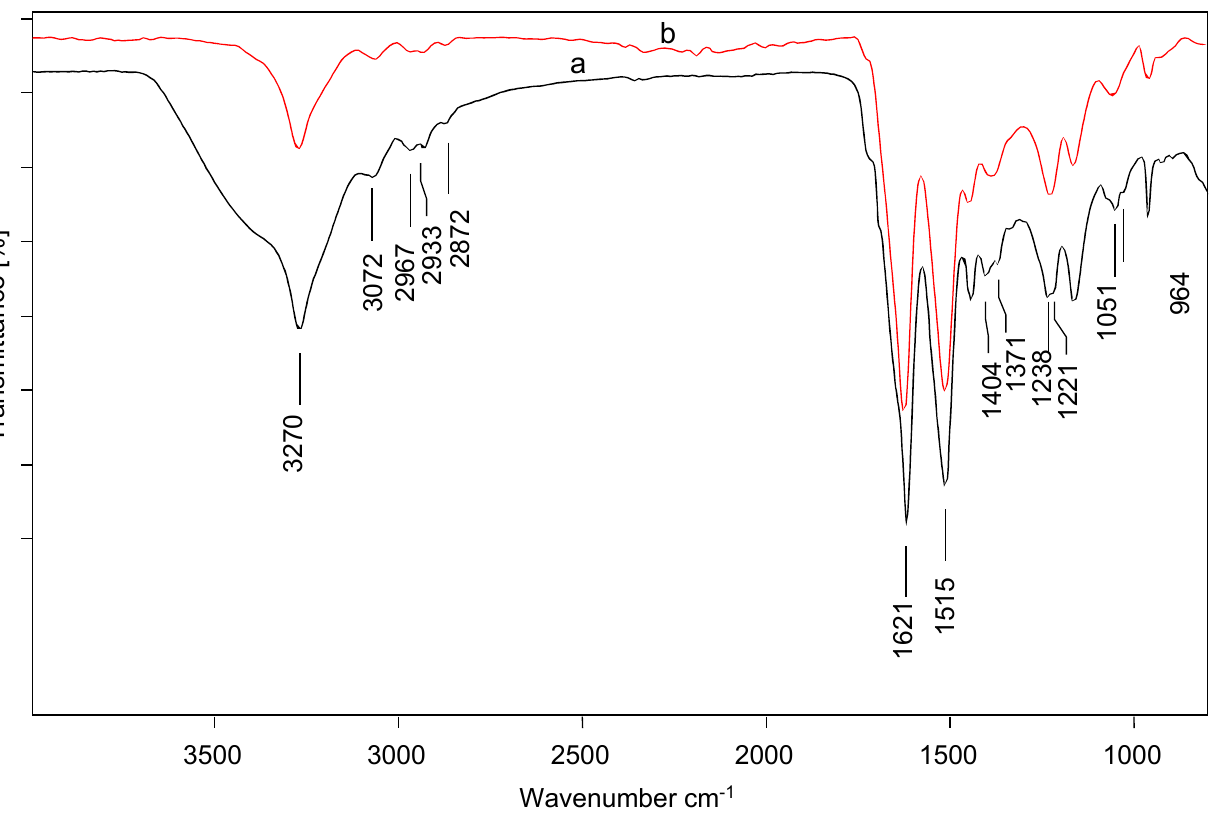
Figure 1. FTIR spectra of silk powder ( a ) before ( b ) after adsorption of pharmaceuticals.